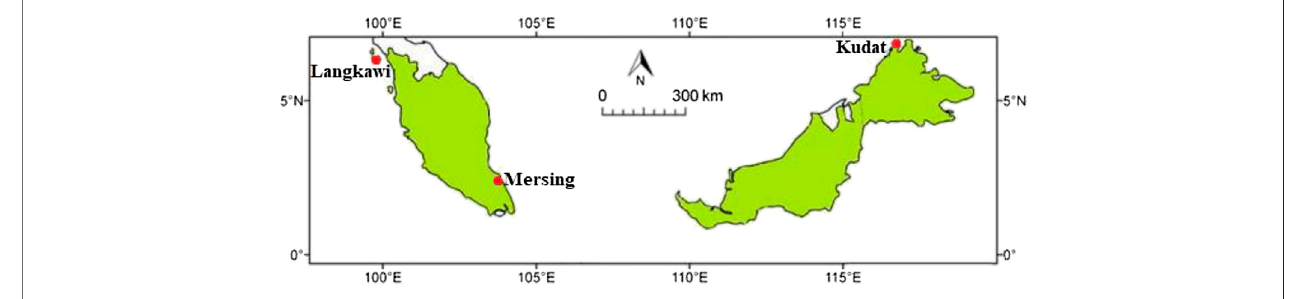
FIGURE 1 | The selected sites in Malaysia.